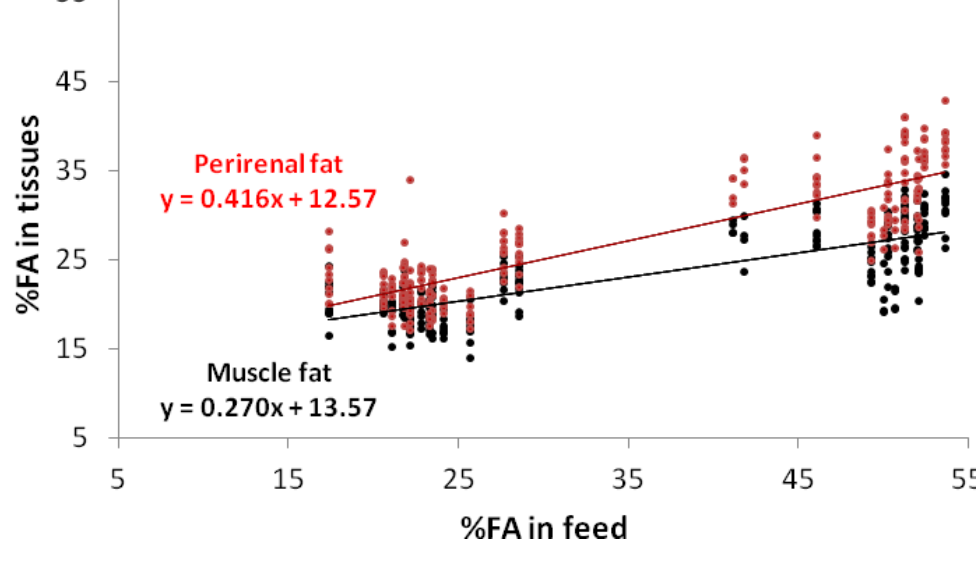
Figure 4. Regressions of the linoleic acid (C18:2 n-6) contents in the muscle fat and perirenal fat, according to their contents in the